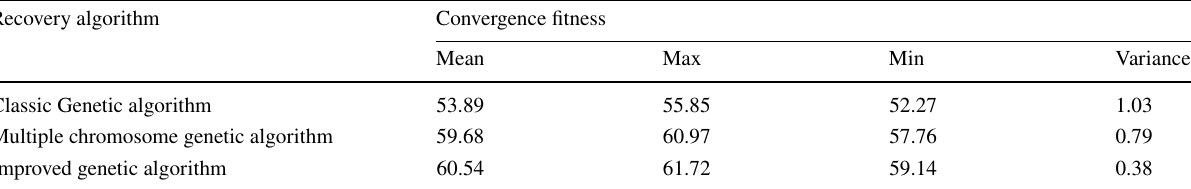
Improved genetic algorithm